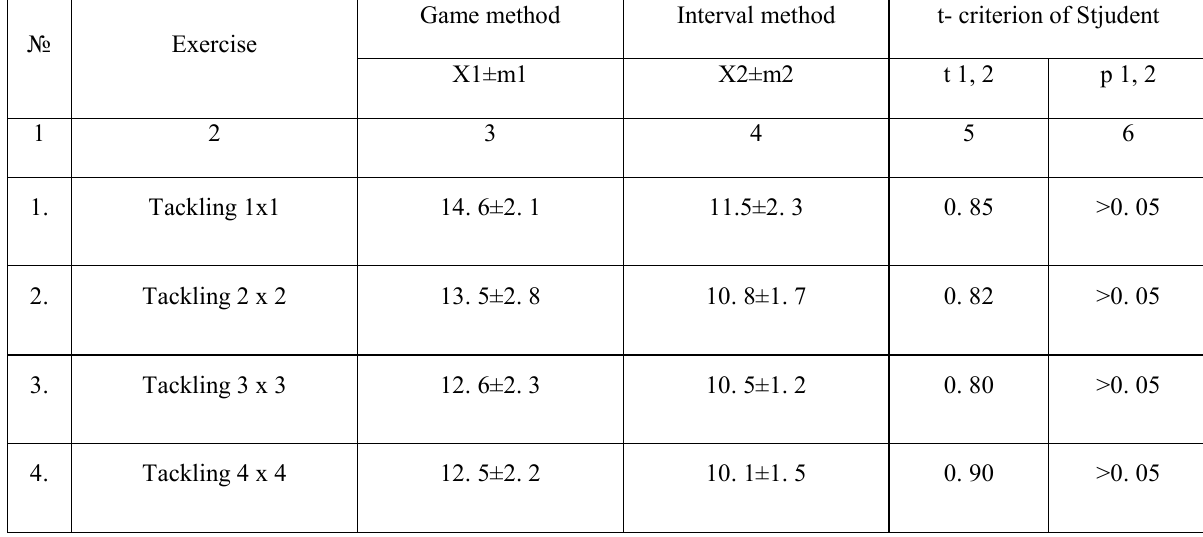
Mean indicators energy losses in football exercises with application of different methods